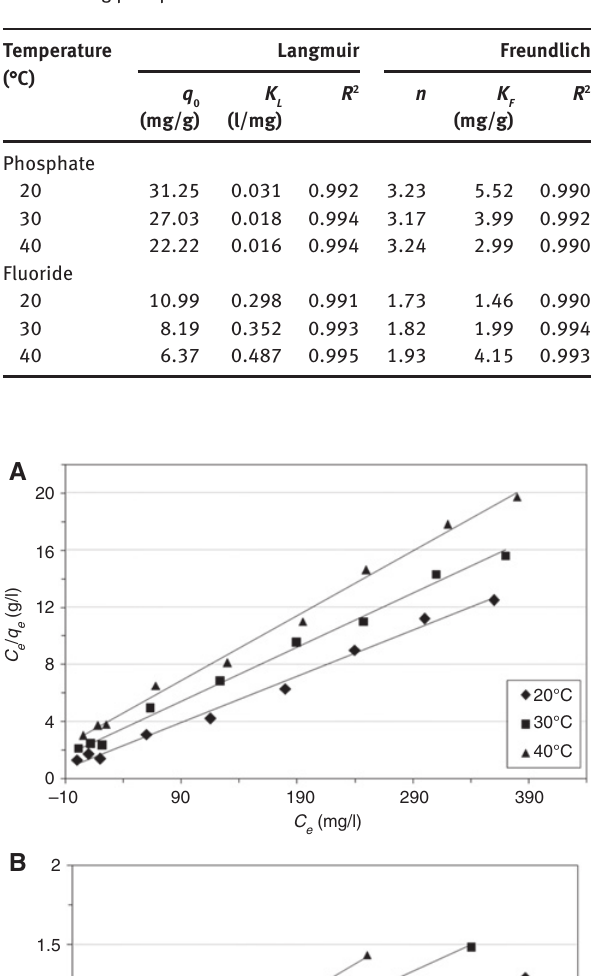
Table 2: Parameters for Langmuir and Freundlich isotherm models for removing phosphate and fluoride.